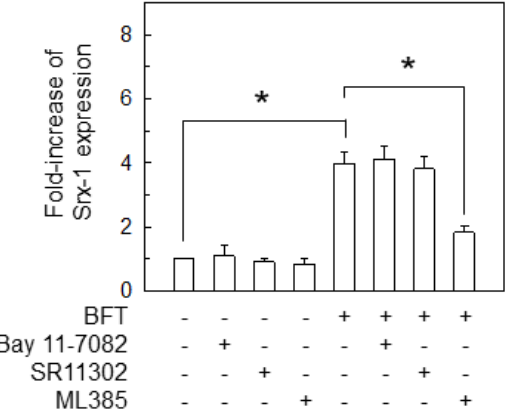
Figure 5. Inhibitory effects of Srx-1-expression by chemical inhibitors. CCD 841 CoN cells were combined with chemical inhibitors such as Bay 11–7082 (50 µM), SR11302 (10 µM) or ML385 (5 µM)